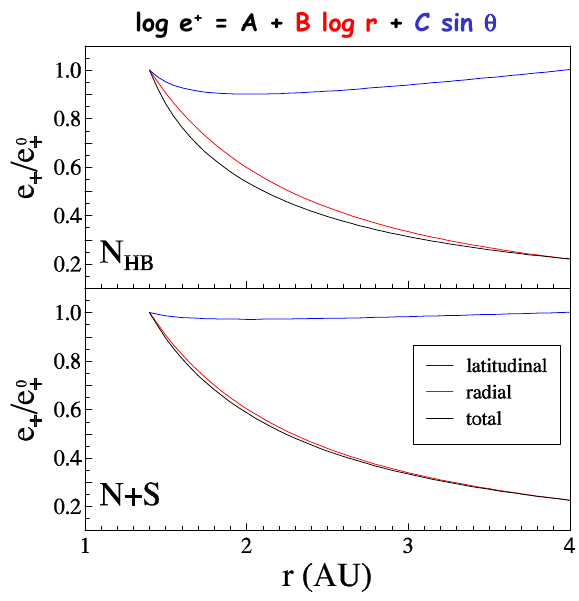
Figure 65: Results from the multiple regression analysis showing radial and latitudinal dependence of the power 𝑒 + associated with outward modes (see Appendix B.3.1). The top panel refers to the same dataset used by Horbury and Balogh (2001). The bottom panel refers to a dataset omni-comprehensive of south and north passages free of strong compressive events (Bavassano et al. , 2000a). Values of 𝑒 + have been normalized to the value 𝑒 + ∘ assumed by this parameter at 1.4 AU, closest approach to the Sun. The black line is the total regression, the blue line is the latitudinal contribution and the red line is the radial contribution. Image reproduced by permission from Bavassano et al. (2002a), copyright by AGU. A further argument in favor of radial vs. latitudinal dependence is represented by the compar- ison of the radial gradient of e + in different regions, in the ecliptic and in the polar wind. These results, shown in Figure 66, provide the radial slopes for e + (red squares) and e – (blue diamonds) in different regions. The first three columns (labeled EQ) summarize ecliptic results obtained with different values of an upper limit (TBN) for relative fluctuations of density and magnetic